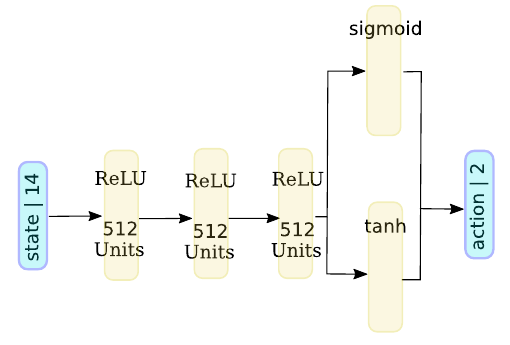
Figure 1. Layout of the actor network for DDPG. The networks has three fully connected layers with 512 neurons each with ReLU activiation. The network receives a 14-dimensional state vector and outputs a 2-dimensional continuous actions vector. The linear velocity is constrained in [0,1] using a sigmoid while the angular velocity is constrained in [-1,1] using a hyberbolic tangent is further multiplied by hyperparameters to limit the maximum linear velocity of the robot to 0 . 25 m / s and the maximum angu- lar velocity to 1 rad / s. The actor outputs, thus the actions, are then sent to the low-level controller to control the motion of the robot’s actuators. The critic network estimates the Q-value of a state-action pair and thus it takes both the state and the action as inputs; however, the action input skips the first layer. The output of the critic is an estimation of the reward. Based on the out- put of the critic network, the weights of both the actor and critic are updated accordingly. Again, the hidden layers are activated by a ReLU function whereas the Q-value is activated by a linear activation. Figure 2 shows the architecture of the critic network.